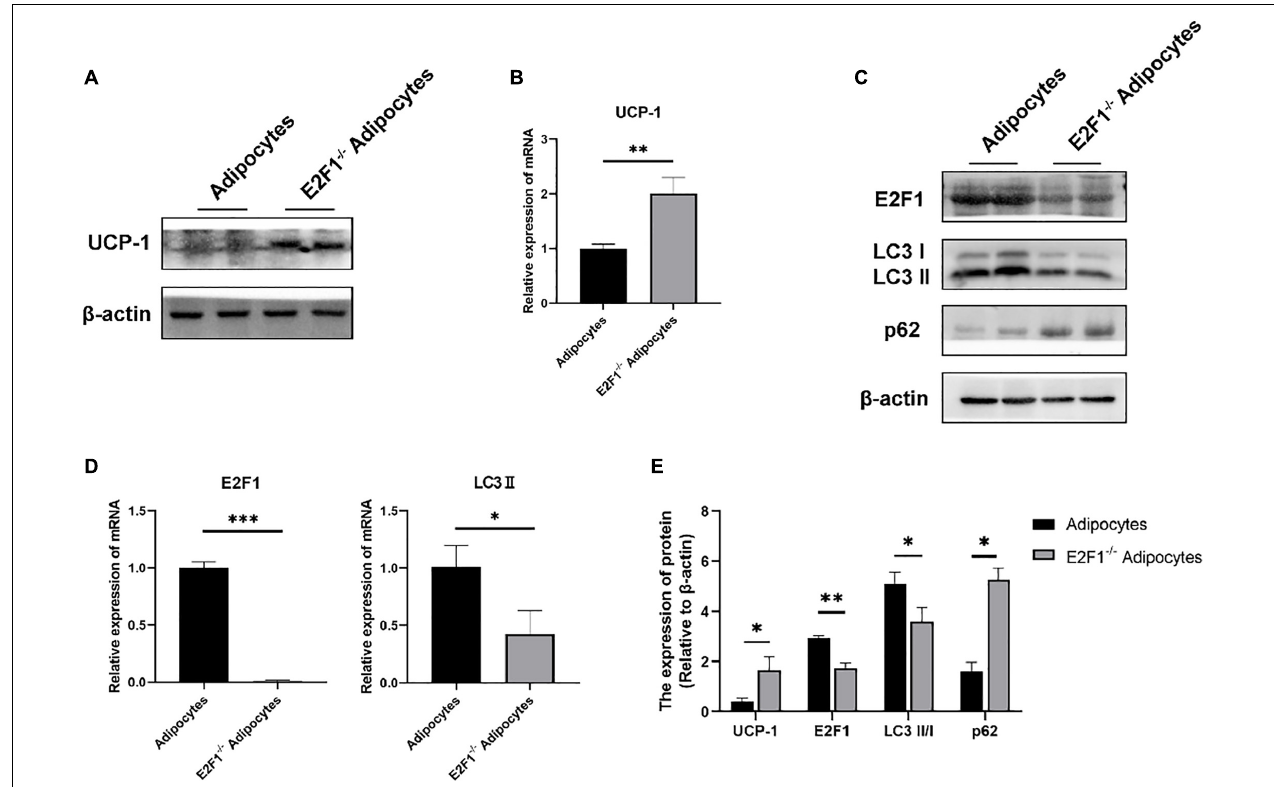
FIGURE 5 | E2F1 knockout increased UCP-1 expression and reduced autophagy gene expressions in adipocytes in vitro . (A) Representative Western Blot image showing the level of UCP-1 protein in adipocytes and E2F1 − / − adipocytes. (B) qRT-PCR analyses of UCP-1 expression at the mRNA level in adipocytes and E2F1 − / − adipocytes. (C) Representative Western Blot image of E2F1, LC3-II/I, and p62 protein levels in adipocytes and E2F1 − / − adipocytes. (D) The qRT-PCR analyses of E2F1, and LC3-II expressions at the mRNA level in adipocytes and E2F1 − / − adipocytes. (E) Quantitative analysis of the protein expressions relative to β -actin, n = 3. ∗ P < 0.05, ∗∗ P < 0.01, ∗∗∗ P <